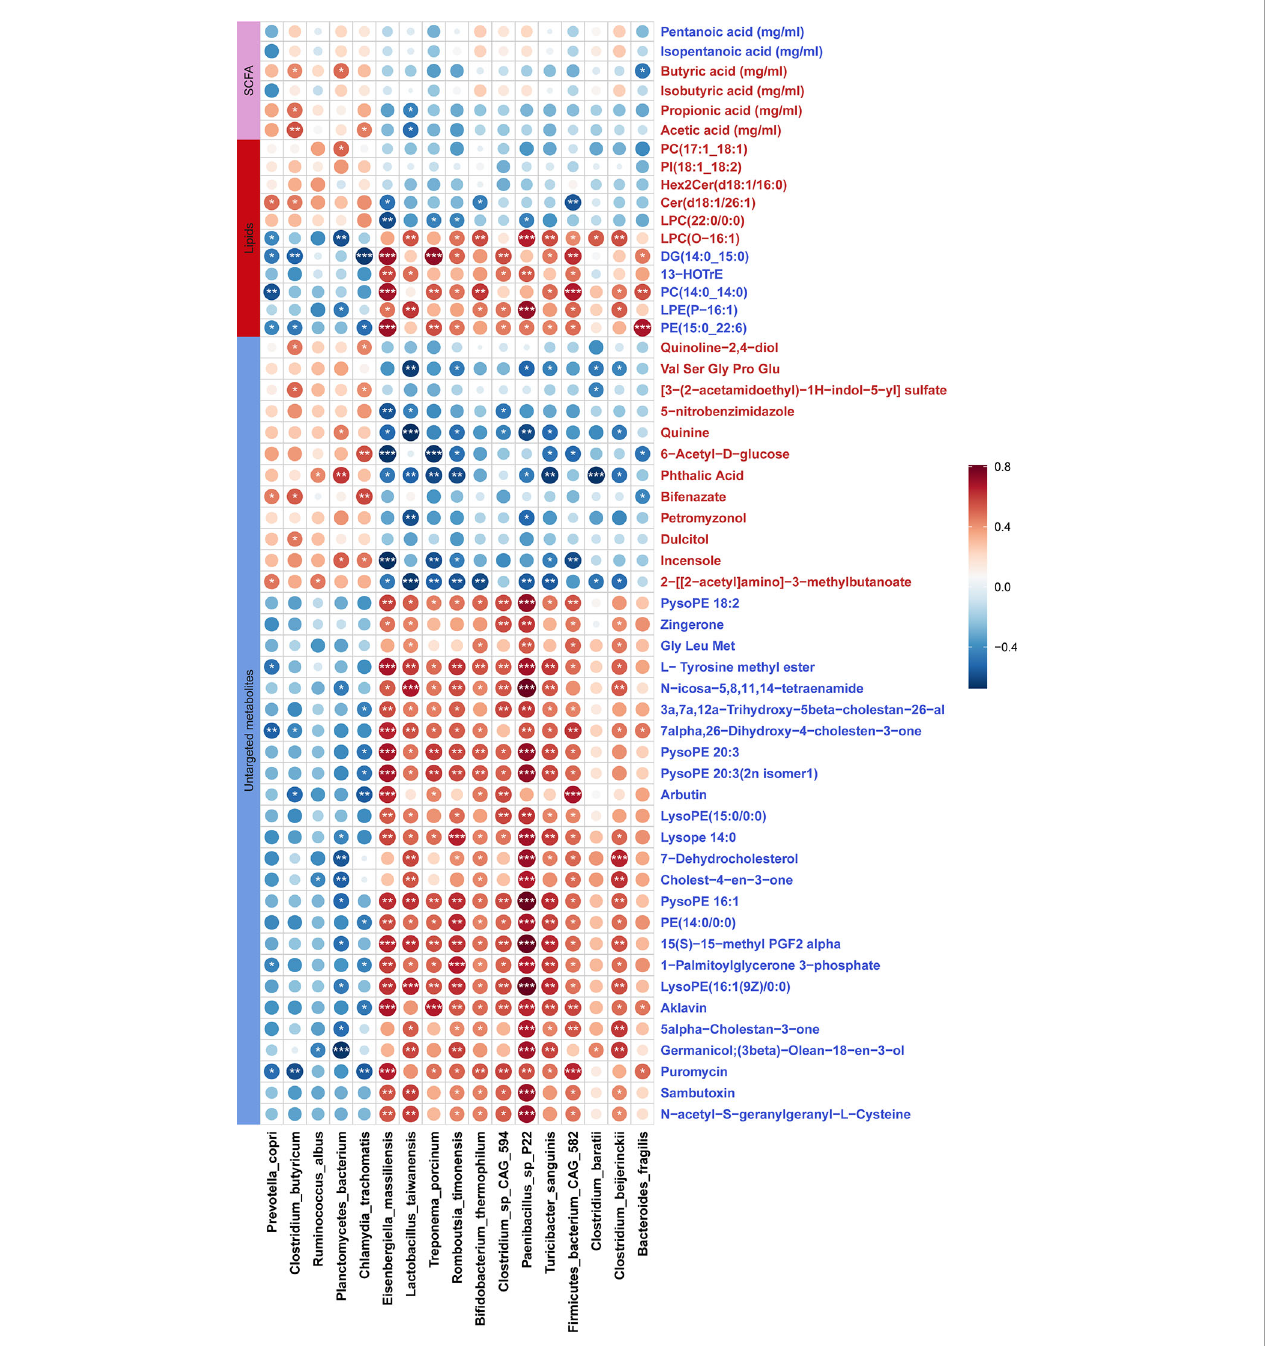
FIGURE 7 Correlations between differential fecal metabolites and differential bacterial species. The sizes of circles indicate the values of Sperman correlation coef fi cient. The stars show the signi fi cance thresholds: * P < 0.05, ** P < 0.01, and *** P < 0.001 by Spearman ’ s rank correlation test. Blue metabolite names represent the metabolites which were enriched in stillbirth sows, and the red metabolite names show the metabolites which were enriched in normal